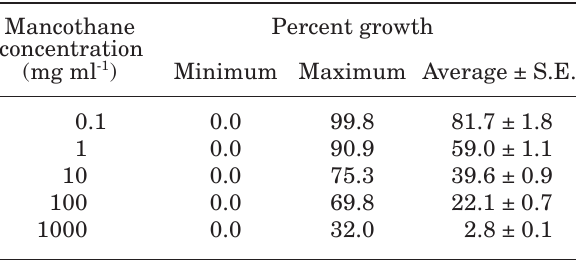
Table 1. Percent growth of 50 isolates of Alternaria solani subjected in vitro to various concentrations of